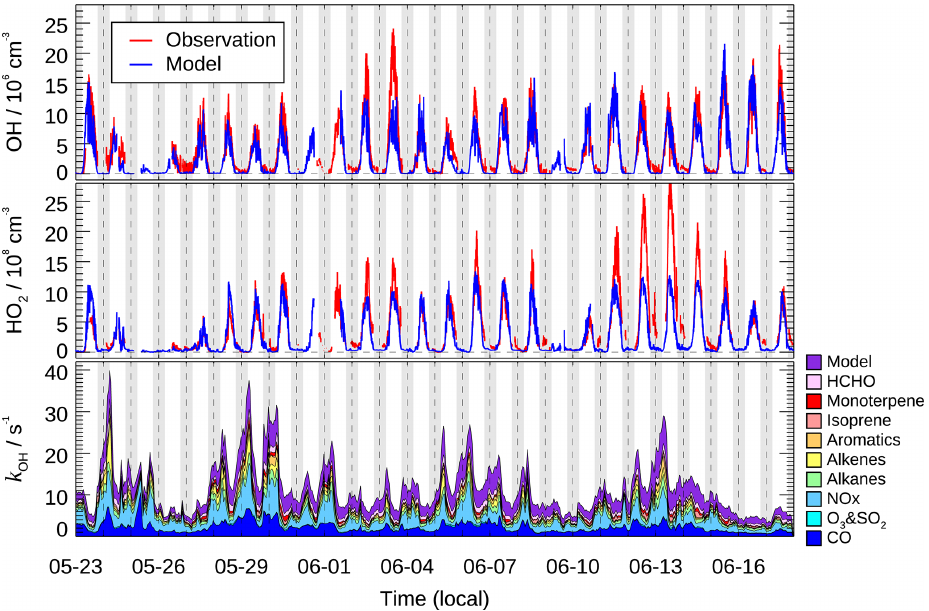
Figure 3. Time series of observed and modeled OH and HO 2 concentration, and the modeled grouped OH reactivity ( k OH ). Vertical dashed lines denote midnight. The grey areas denote nighttime.